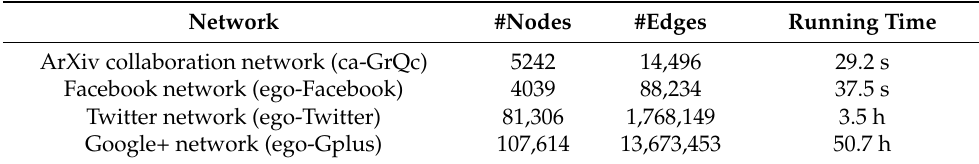
Table 1. Running times for various real-world social networks from the SNAP dataset [25] using the CC algorithm (Algorithm 2). All values were calculated with L max = 50 on a workstation with two Intel Xeon X5690